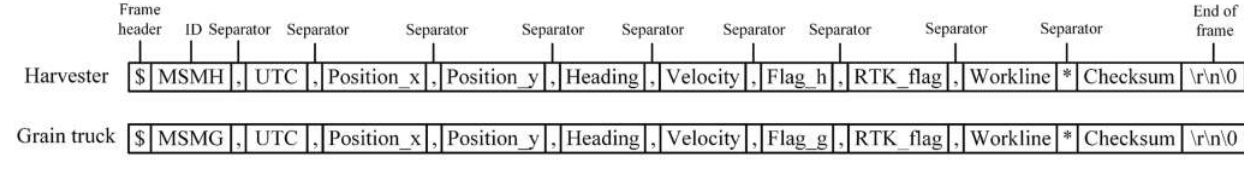
Figure 3. Definition of wireless communication data